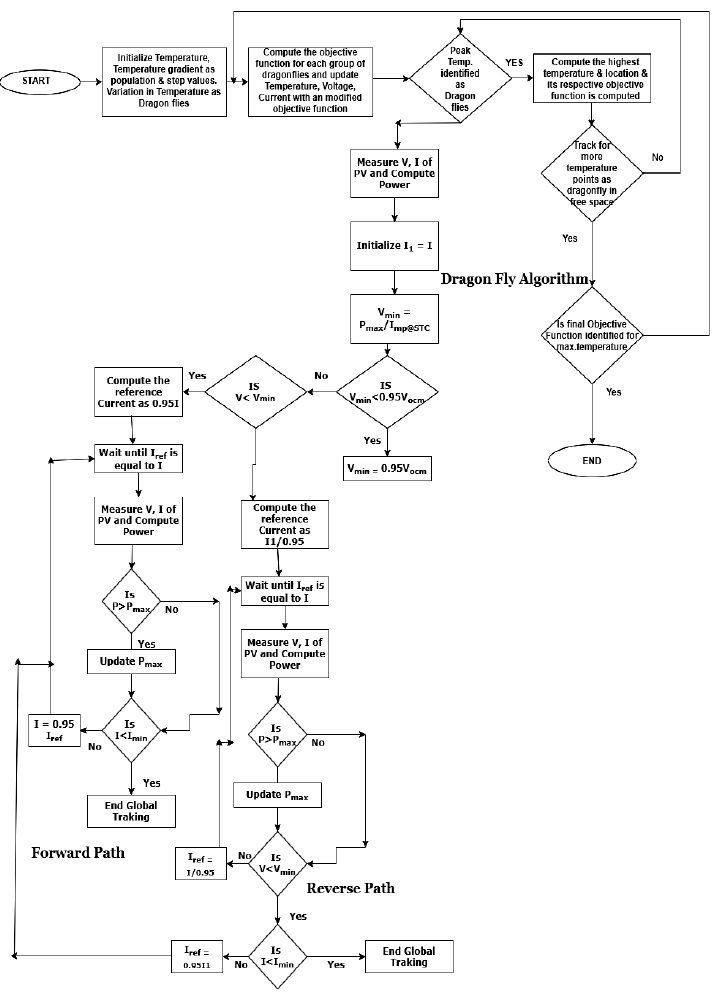
Figure 5. Flowchart of the dragonfly MPPT forward and reverse algorithm.